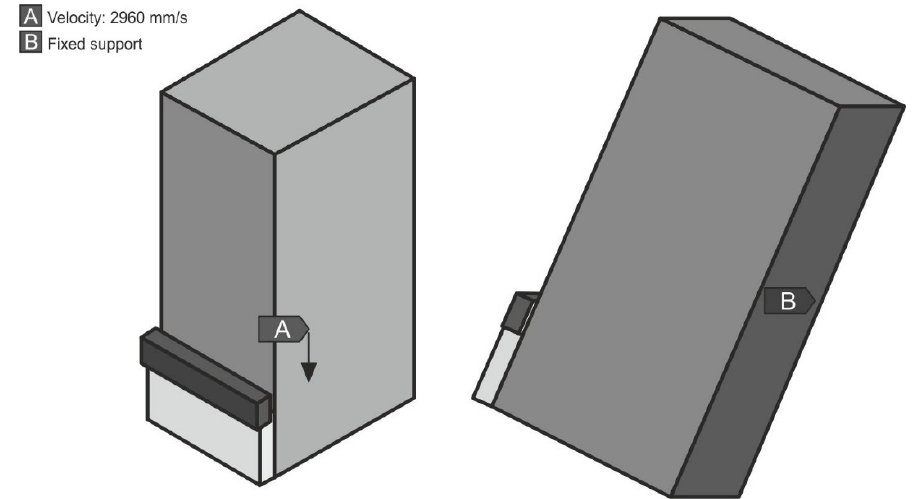
Figure 10. Boundary conditions: (A) speed 2960 mm / s (given to the element that simulates the hammer’s impactor); (B) surface fixing through taking away six degrees of freedom.